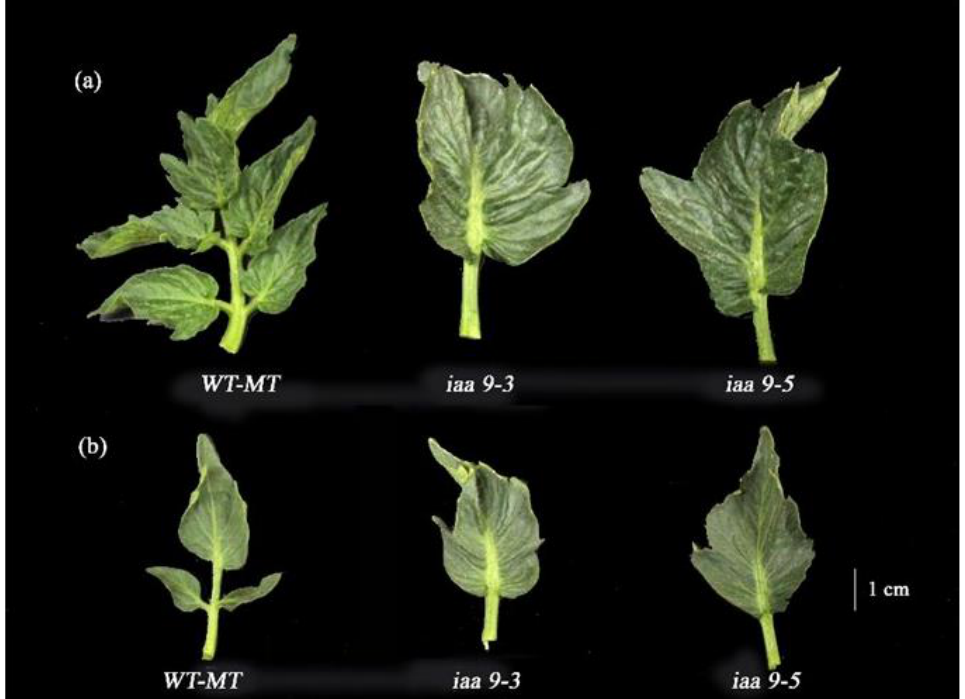
Figure 2. ( a ) WT-MT, iaa9-3 , and iaa9-5 leaf under normal conditions; ( b ) WT-MT, iaa9-3 , and iaa9-5 leaf under heat stress conditions.